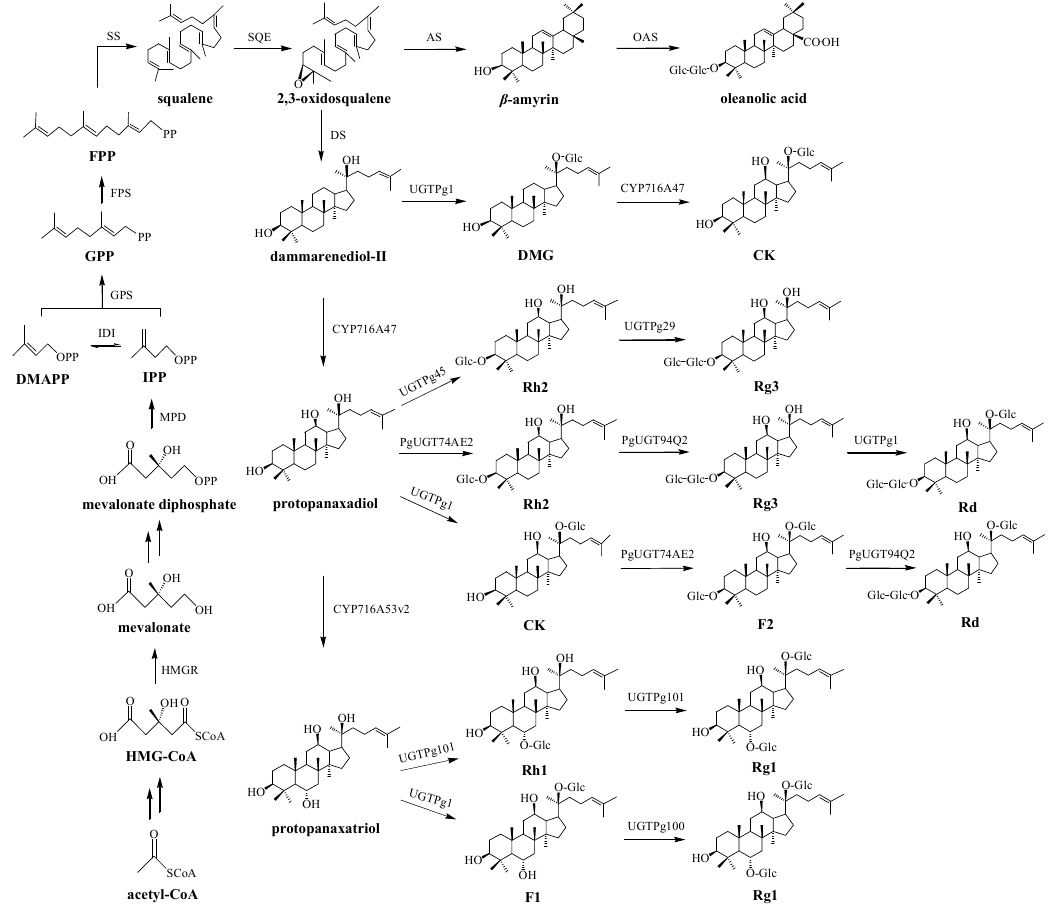
Figure 1. Biosynthetic pathway of ginsenosides.